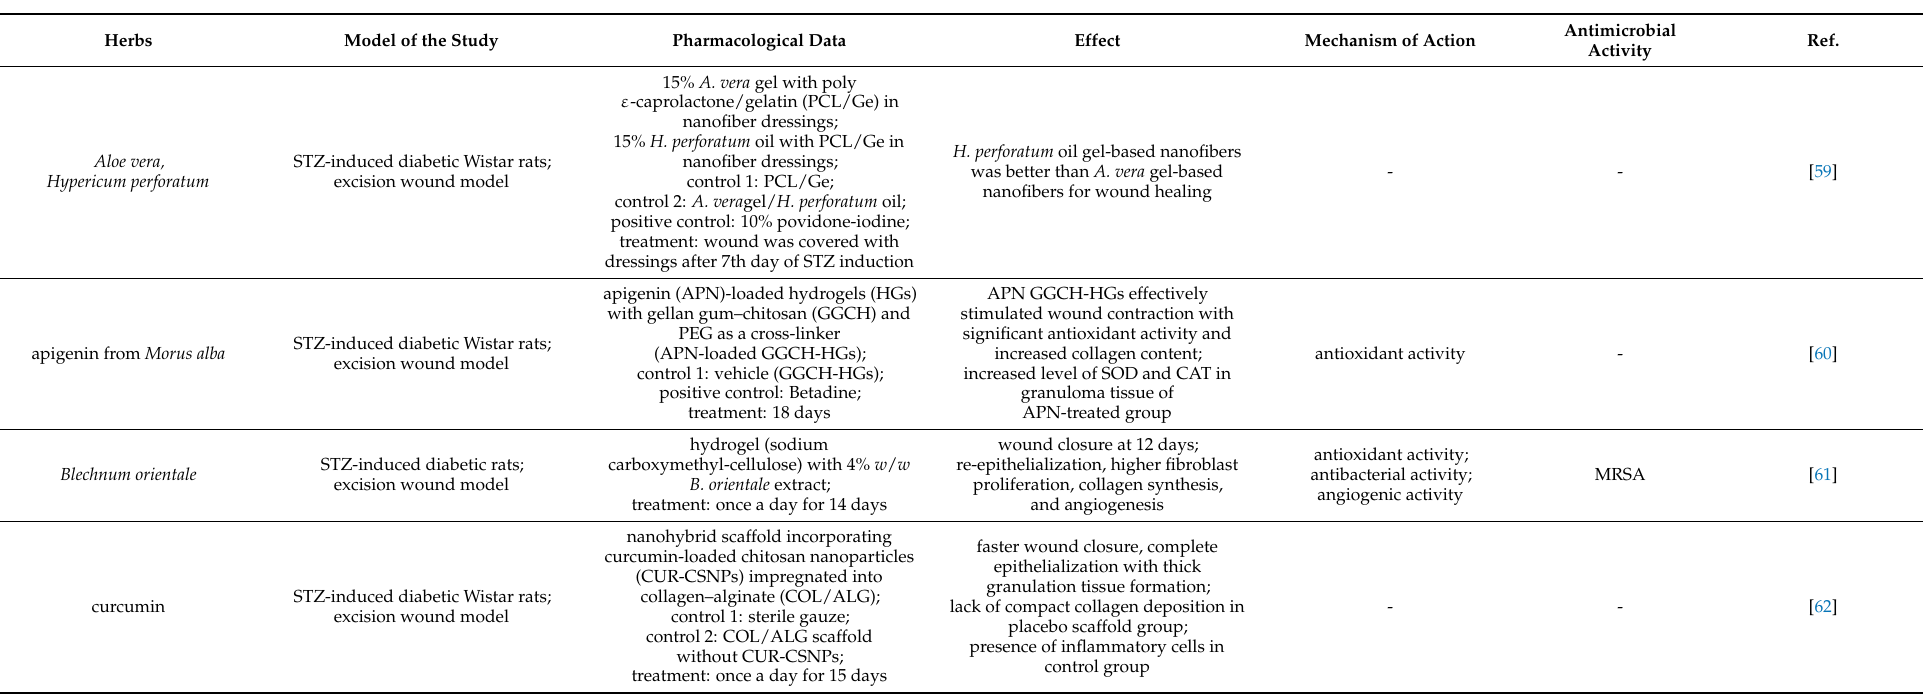
Table 3. Herbal products and their active constituents loaded on dressings used for diabetic wound healing, animal-based